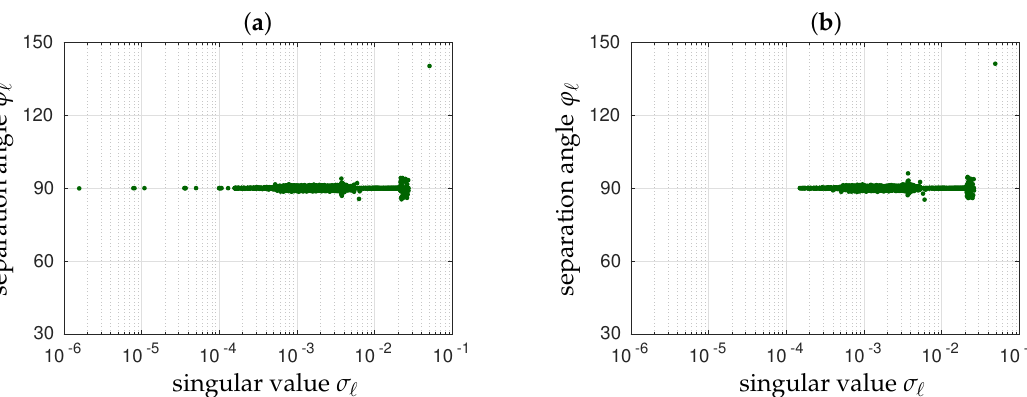
Figure 12. Separation angles ϕ (cid:96) between the singular vectors V (cid:96) of (cid:101) G and the brightness temperature maps (cid:101) T corresponding to the apodized maps (cid:101) T of Figure 8 retrieved without radiometric noise for two values of the shortest spacing of the cross-shaped array shown in Figure 4: ( a ) d = 0.69 λ and ( b ) d = 0.71 λ . Only the first 13,861 largest singular values shown in green in Figure 5 are reported here inasmuch as the other ones are discarded prior to the inversion of (cid:101) G , the corresponding singular vectors do not contribute to (cid:101) T .